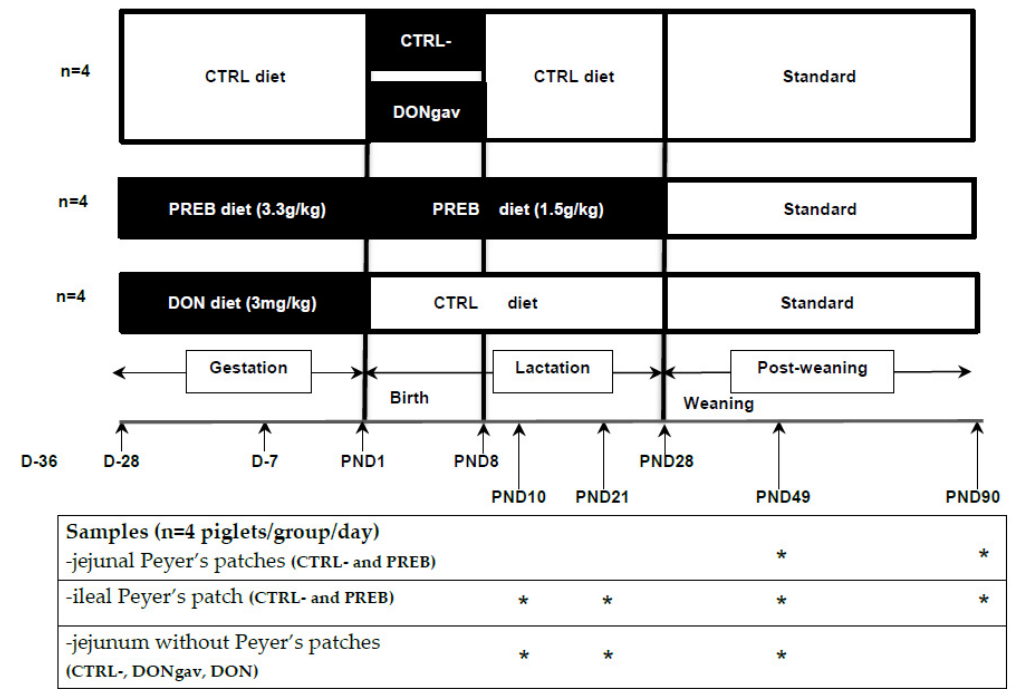
Figure 1. Experimental design. Twenty-eight days before the expected time of farrowing and until the end of the lactation (PND28), two groups of sows were fed either a maltodextrin diet as a control (CTRL group, n = 4) or a scFOS-supplemented diet (PREB group, n = 4). The third group of sows were fed with DON-contaminated diet (DON group, n = 4) during the gestation period only. Piglets from PREB and DON sow litters were selected for PREB and DON piglet groups, respectively. Within the CTRL group litter, piglet received daily a DON solution (DONgav) or excipient (CTRL-, negative control for PREB and DON diets) from PND1 to PND8 orally. Piglets were euthanized at PND10, PND21, PND49 or PND90. The stars in the table represented the PND when jejunal with or without Peyer’s patches and ileal Peyer’s patches were analyze.